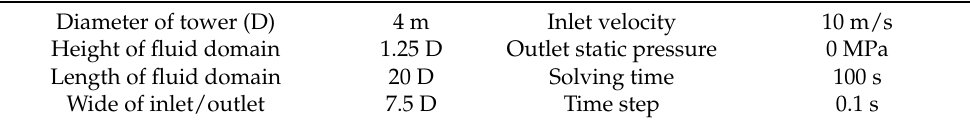
Table 1. Boundary conditions of the computational fluid domain.